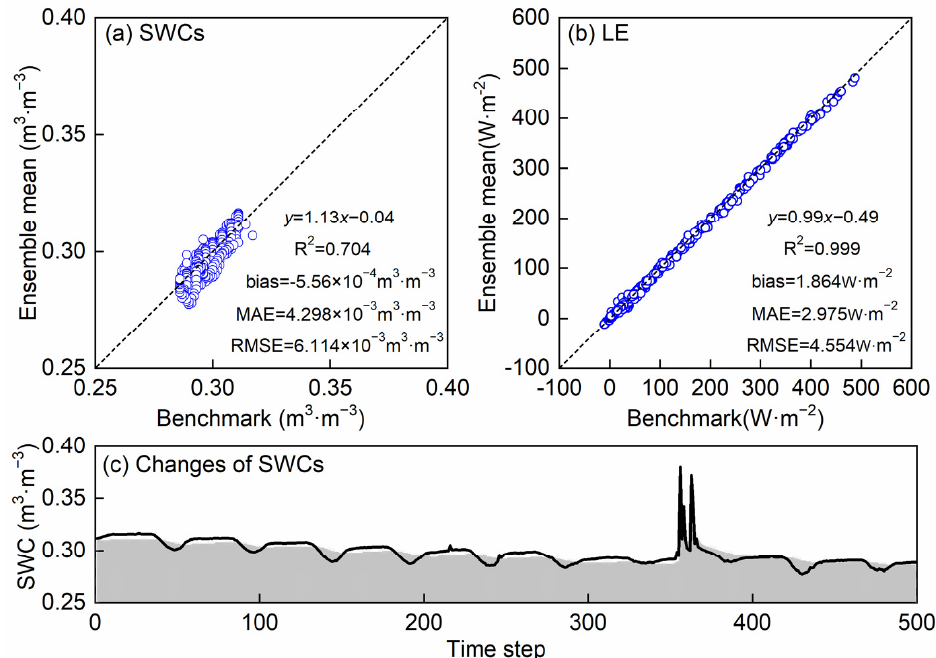
Figure 12. The comparison of benchmark run and ensemble mean.